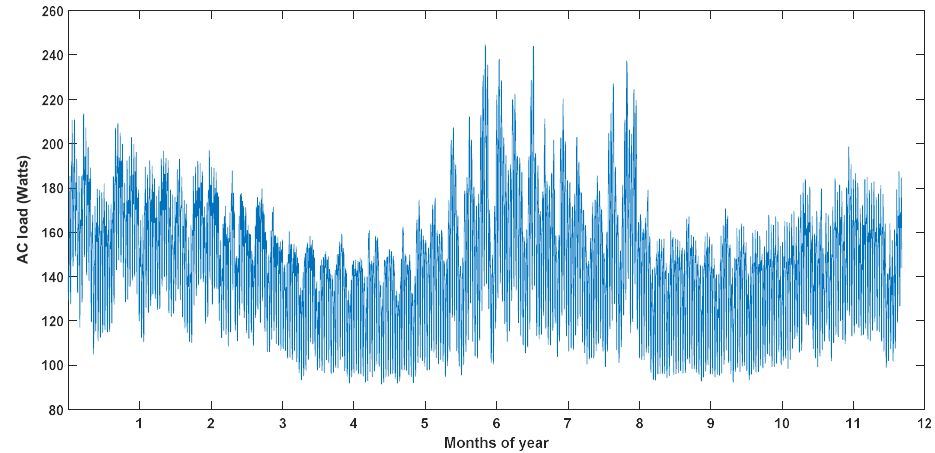
Figure 3. Air Conditioner (AC) Load variations during complete year .